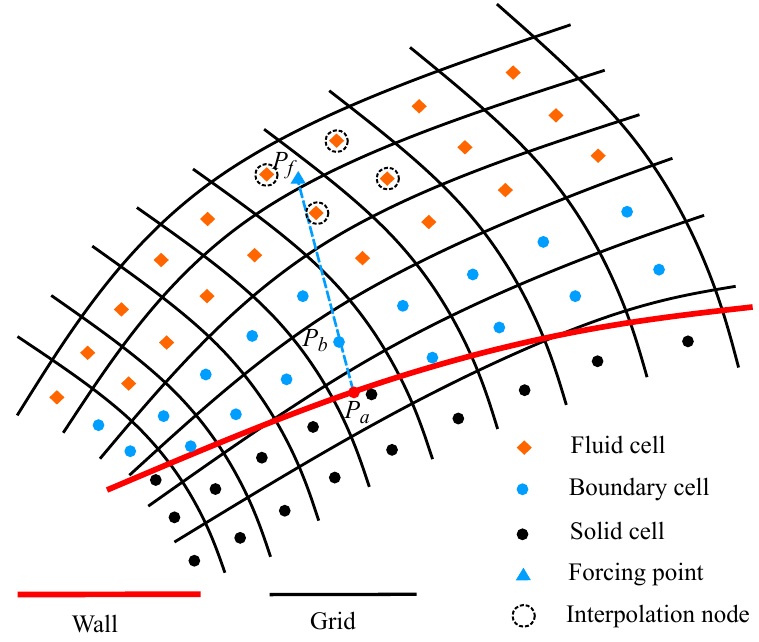
Figure 2. Cell classification for the curvilinear grid near the